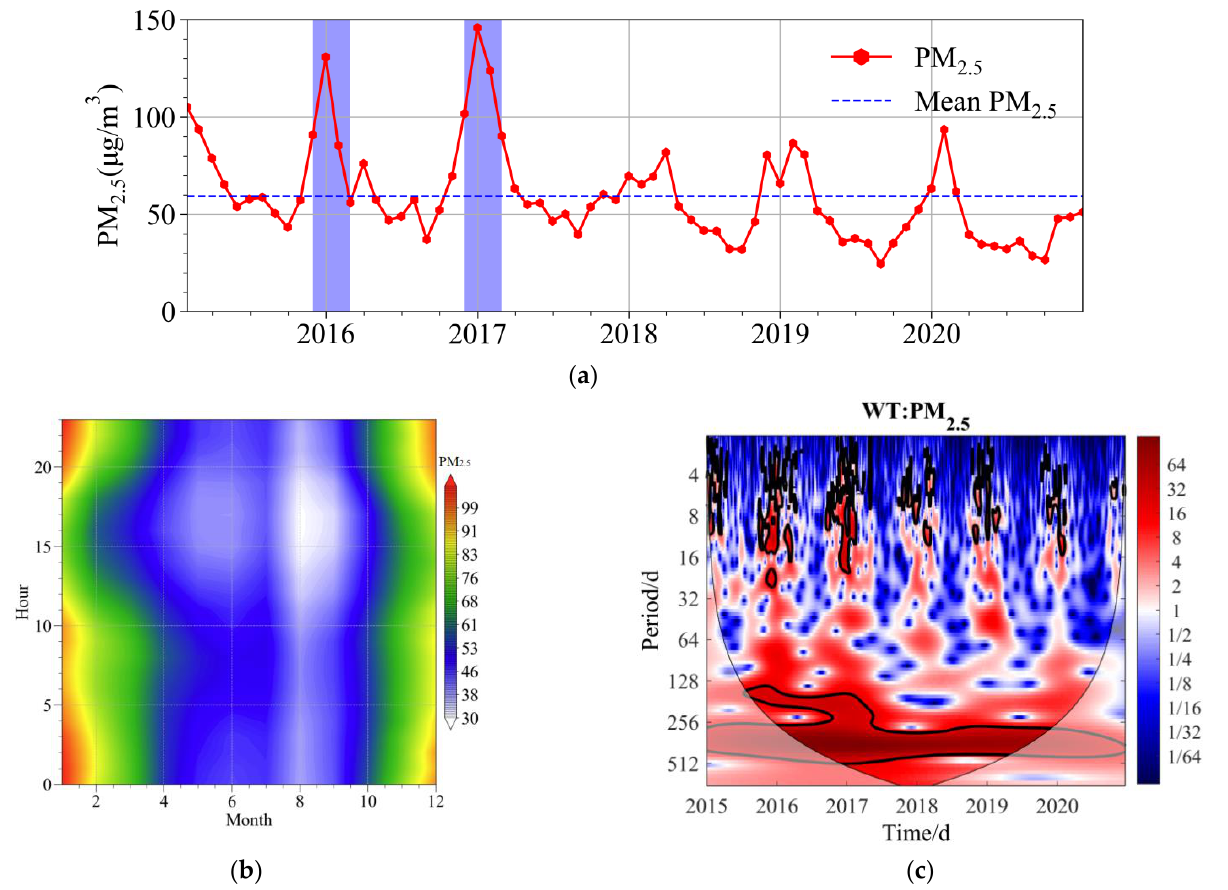
Figure 2. Temporal, diurnal variation and WT of PM2.5 in the BTH from 2015 to 2020.